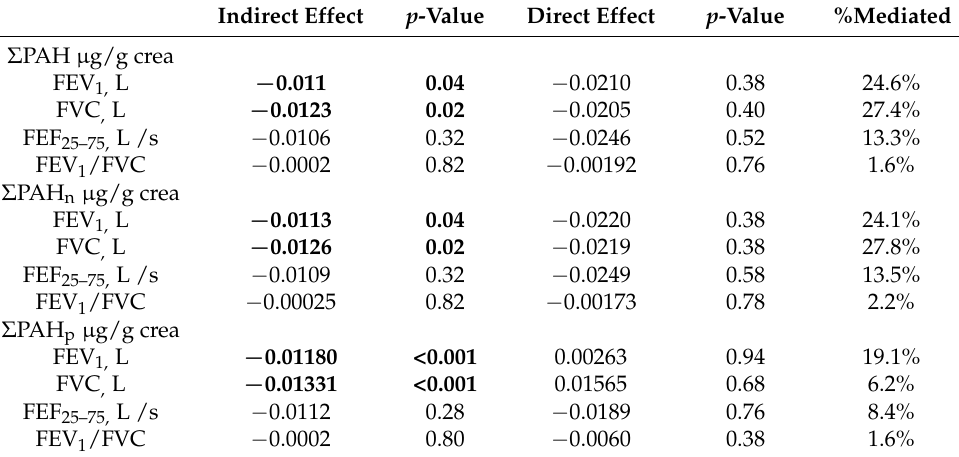
Table 6. Mediation Analysis ( n = 50): PAHs indirect and direct effects on spirometry